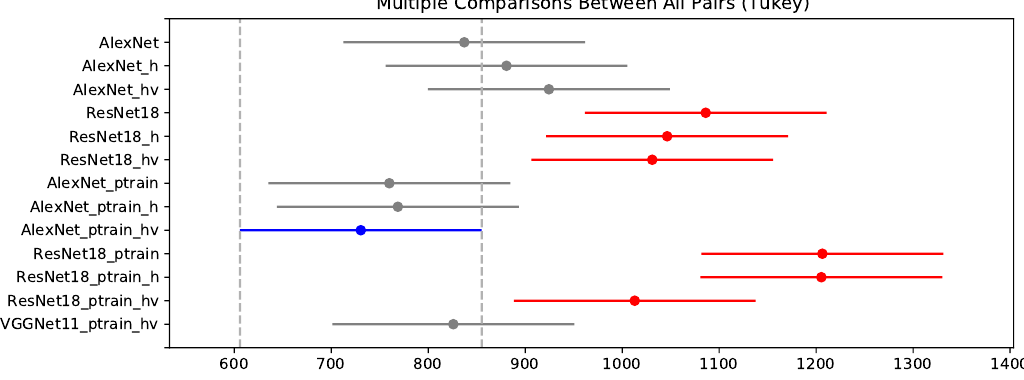
Figure 4. Mean and the 95% confidence interval of a pos-hoc Tukey’s HSD test performed on MAE